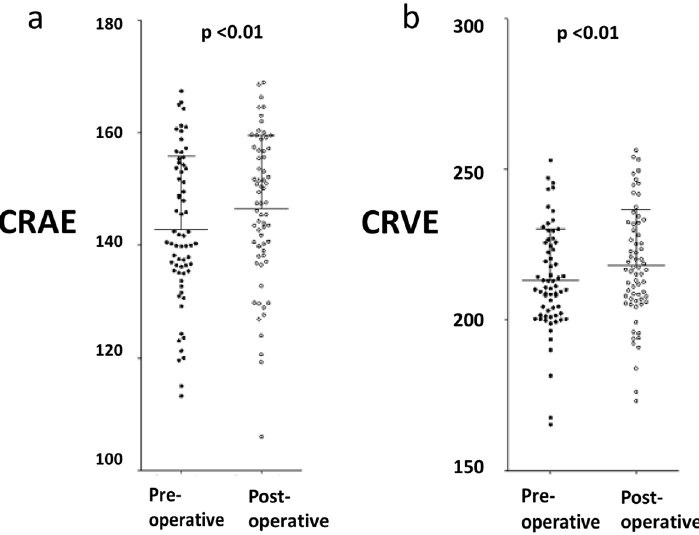
Figure 1. Arteriole (CRAE) and venular (CRVE) calibre pre and post-operatively.